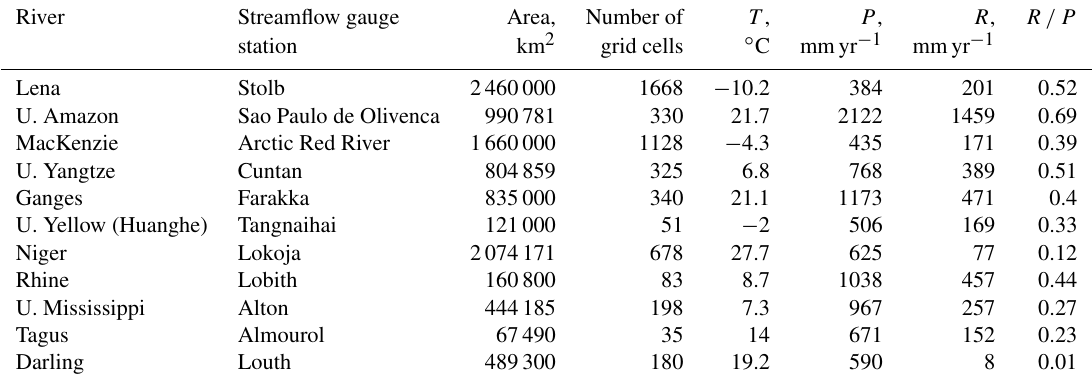
Table 1. River basins with their area and the number of calculational grid cells; gauge stations; averaged over 1971–2000 air temperature T , precipitation P , river runoff R and runoff ratio R /P . The values of T , P and R are taken from Krysanova and Hattermann (2017). River Streamflow gauge Area, Number of T , P , R , R /P station km 2 grid cells ◦ C mmyr − 1 mmyr − 1 Lena